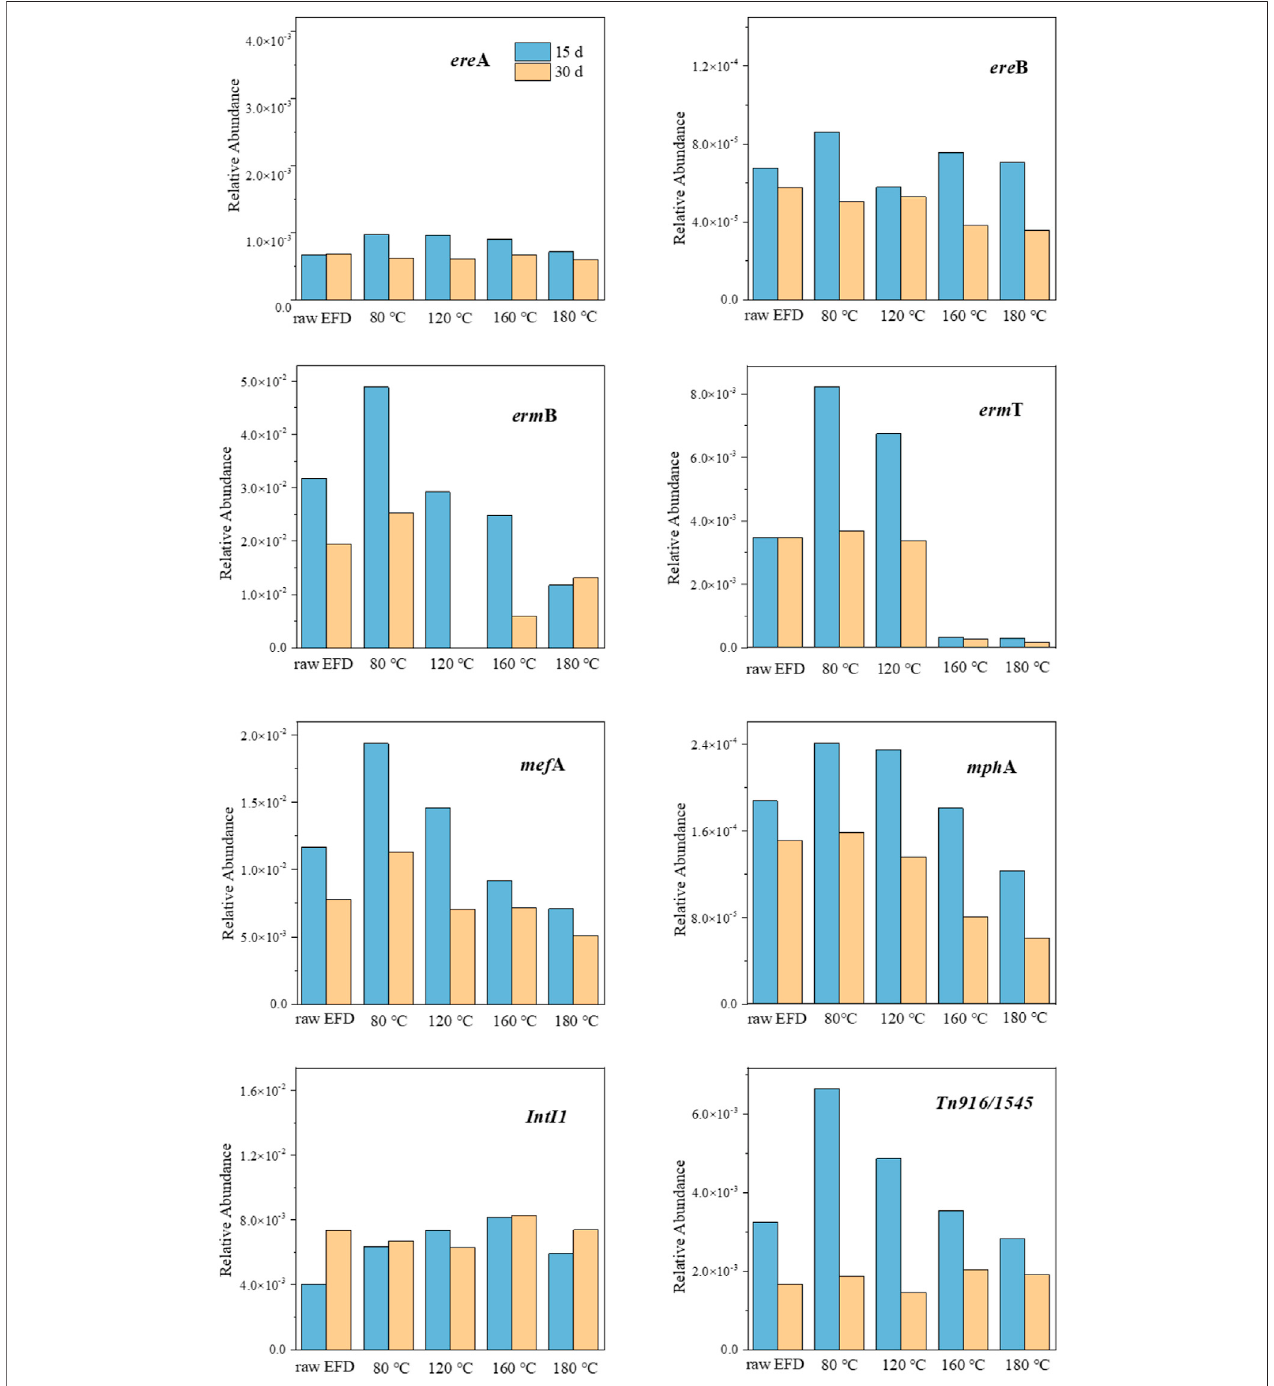
FIGURE 3 | Relative abundance changes of antibiotic resistance genes (ARGs) and mobile genetic elements (MGEs) during AD of the erythromycin fermentation dregs (EFD) with different hydrothermal treatments.